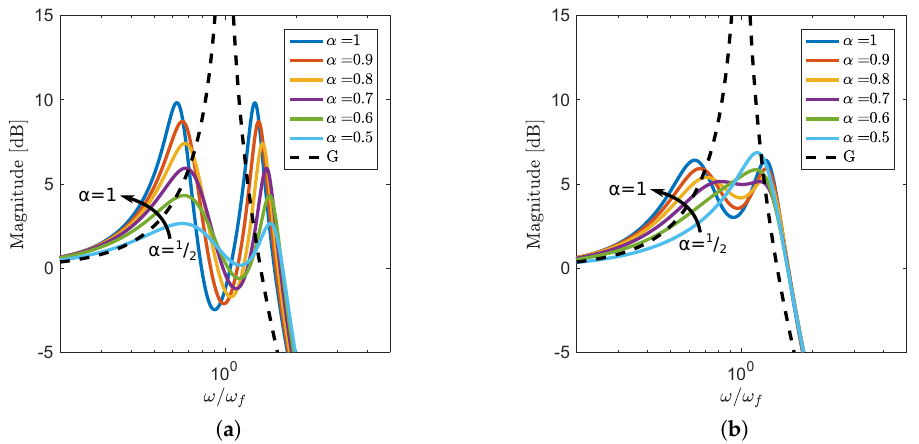
Figure 5. Closed-loop frequency response T for a lightly damped plant and fractional-order attenuators with ( a ) ζ f , α = 1 = 0.2 , ( b ) ζ f , α = 1 = 0.4 and different α . Values of ω f are adjusted for maximal